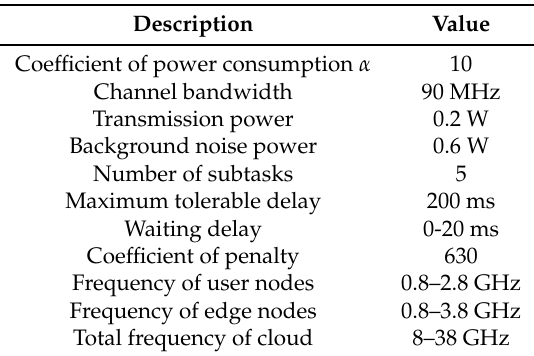
Table 4. Simulation parameters.